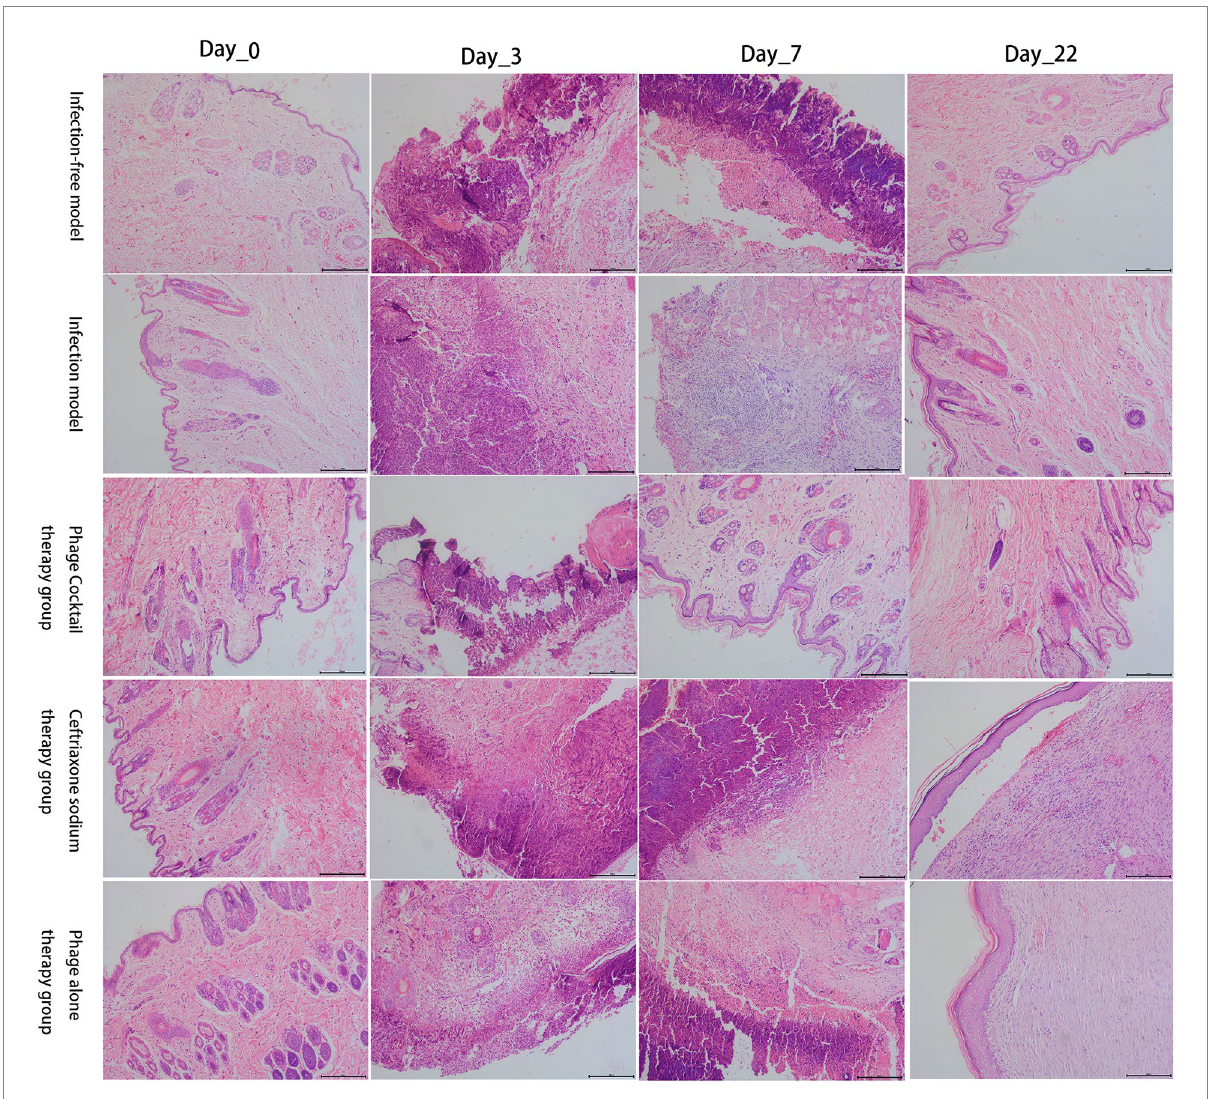
FIGURE 7 Histological analysis of the healing process of damaged skin in five groups of New Zealand rabbits. Hematoxylin and eosin (H&E) staining